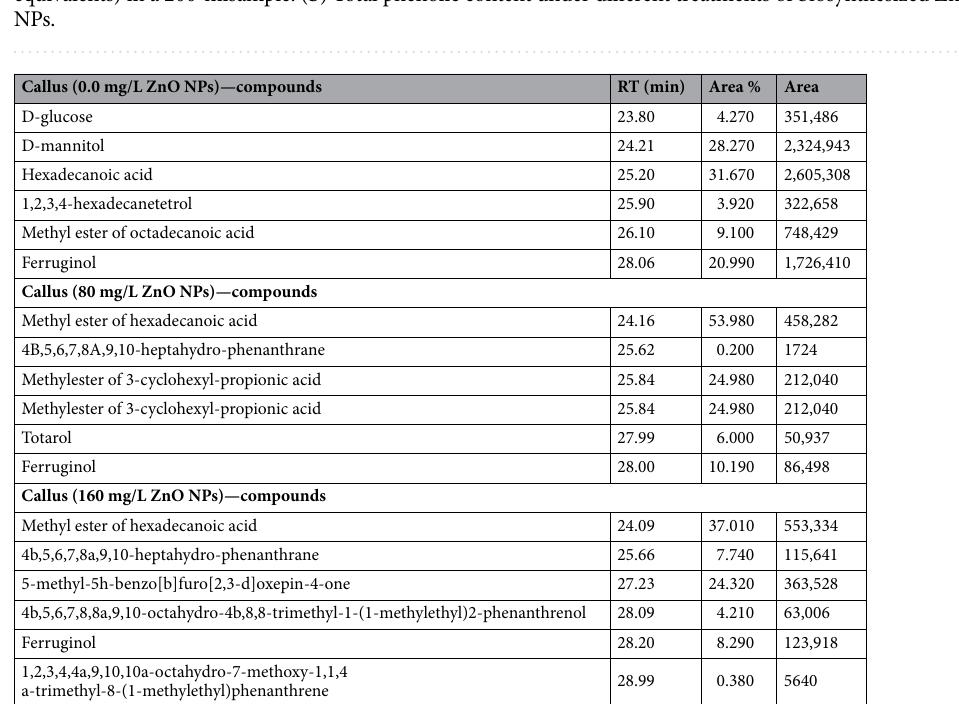
Table 2. The effect of different concentrations of biosynthesized zinc oxide nanoparticles on bioactive compounds of callus from J. procera.